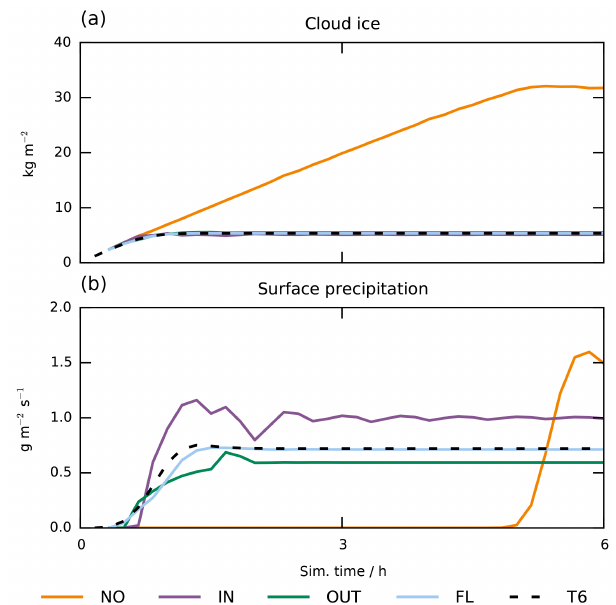
Figure 4. Results from a sedimentation test case in the single- column model. (a) Cloud ice and (b) surface precipitation. Colors indicate different simulation setups: T6 uses a time step of 6s. In the simulations NO, IN, OUT and FL, a global time step of 600s is used. They differ in their sub-stepping: FL has full sub-stepping with online computation of n in and n out ; IN sets n out = 1 and only uses the inner loop with online computation of n in and vice versa for the simulation OUT. NO does not use any sub-stepping with constant n in = n out = 1.